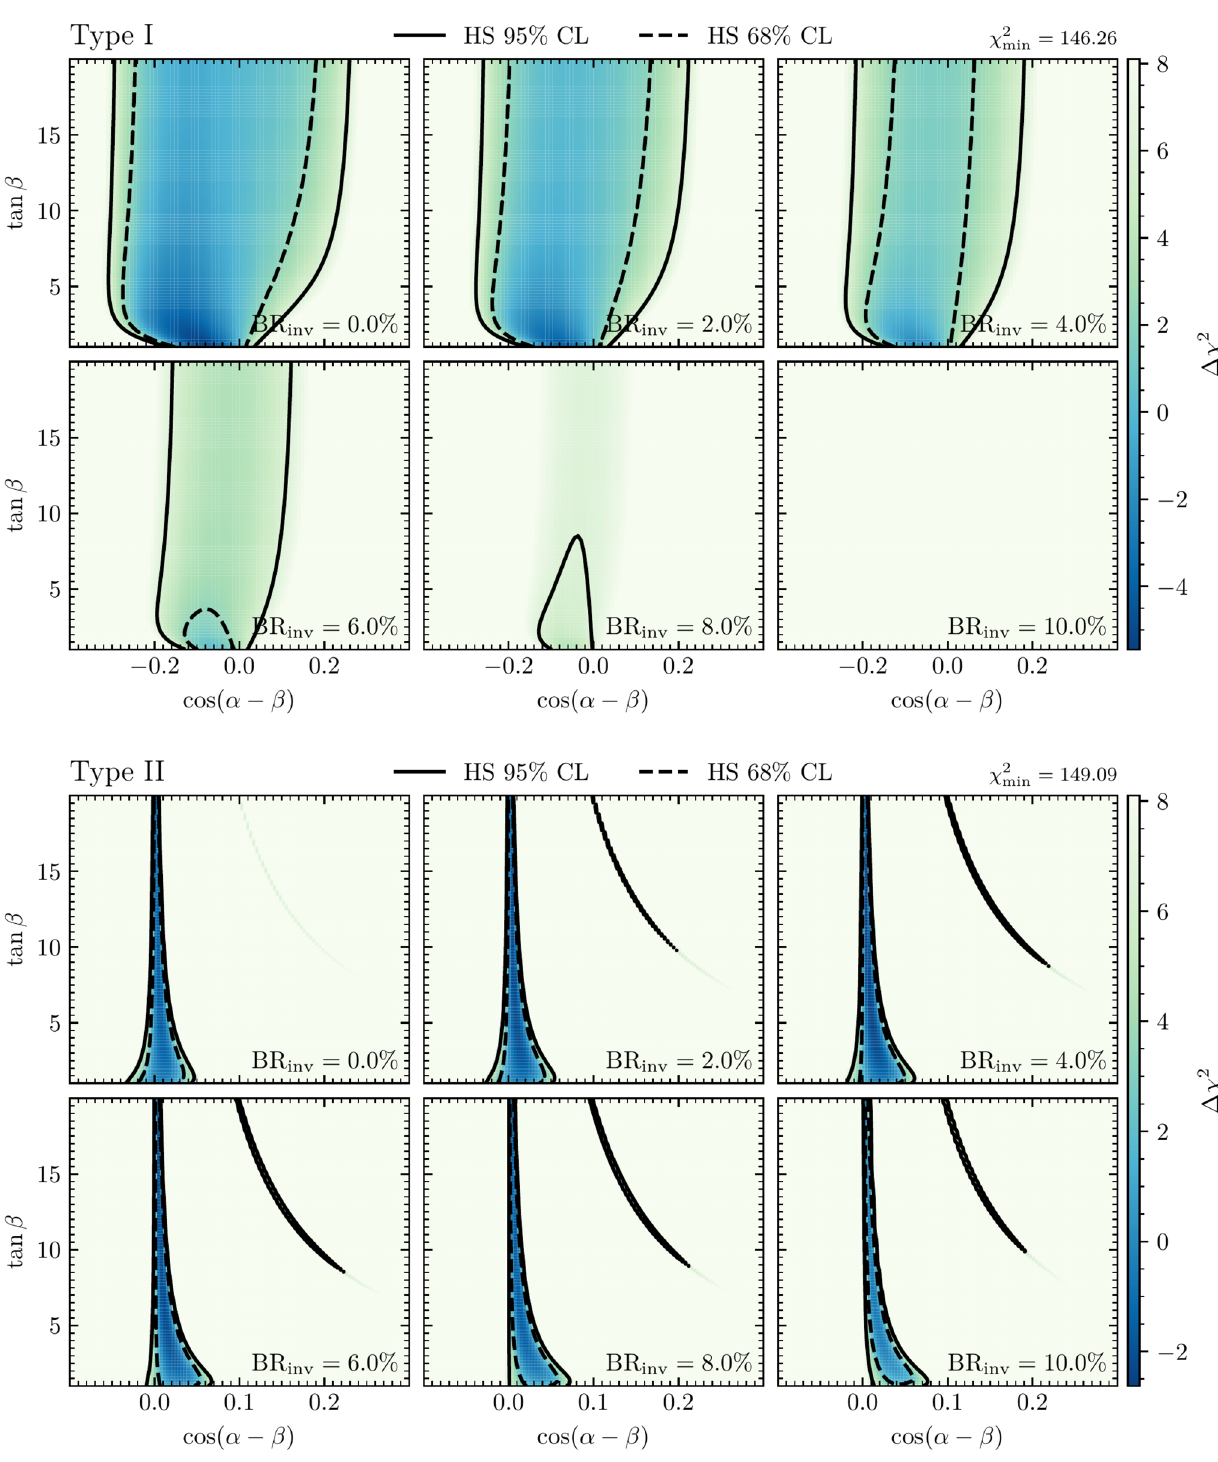
Fig. 10 (cid:10)χ 2 -distribution in the { cos (α − β), tan β } plane for different values of BR inv in the type I (top) and the type II (bottom). The dashed black and the solid black lines indicate the exclusion limits at the 68% and the 95% confidence level,